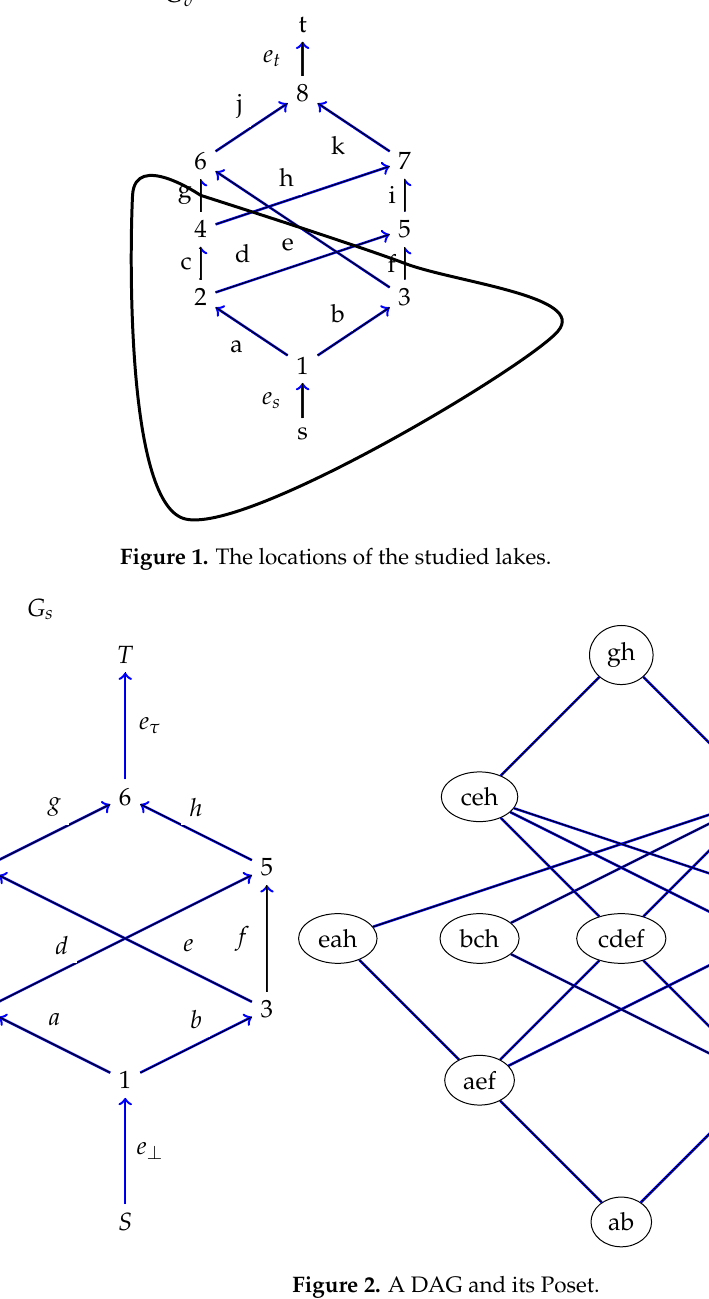
Figure 2. A DAG and its Poset.